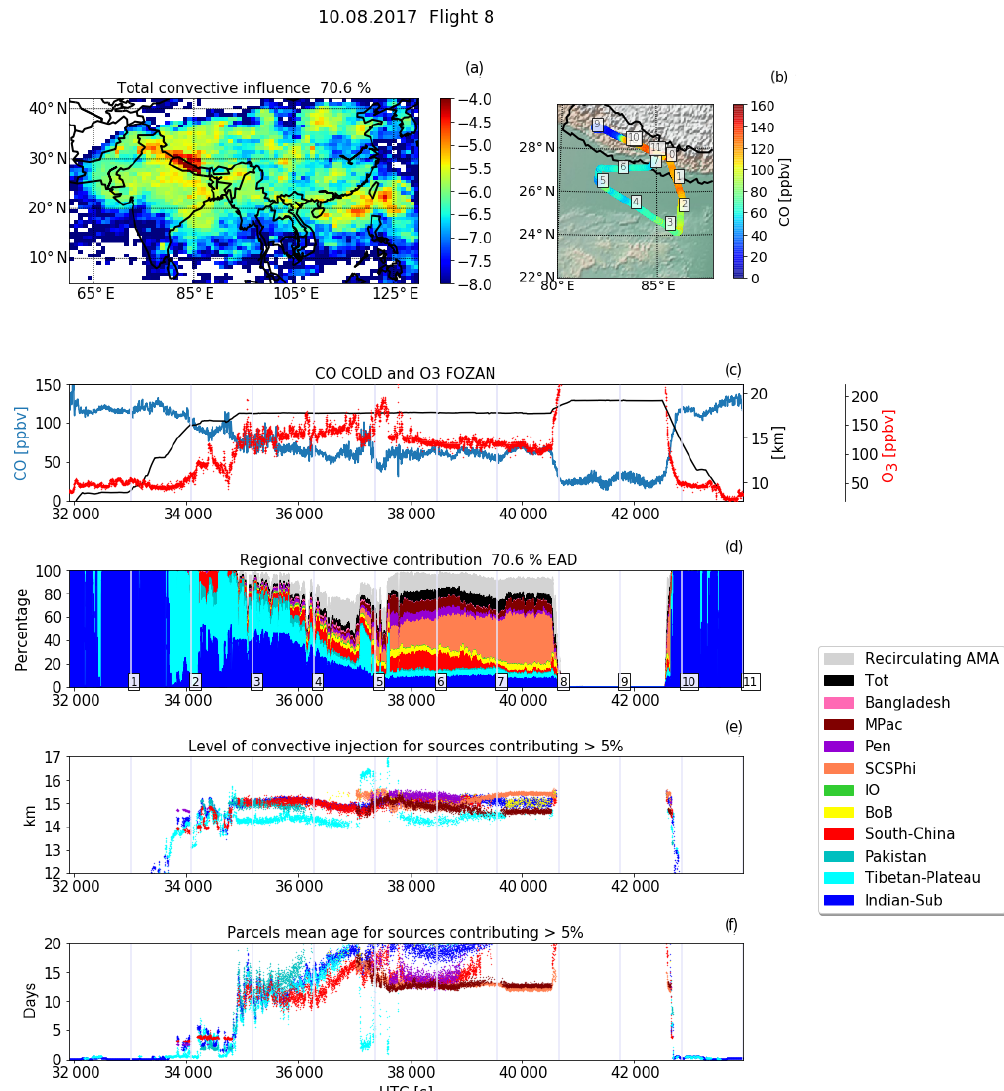
Figure 9. As in Fig. 7 but for F8 (10 August 2017). Panel (c) also reports the O 3 concentration from the FOZAN instrument (not available in